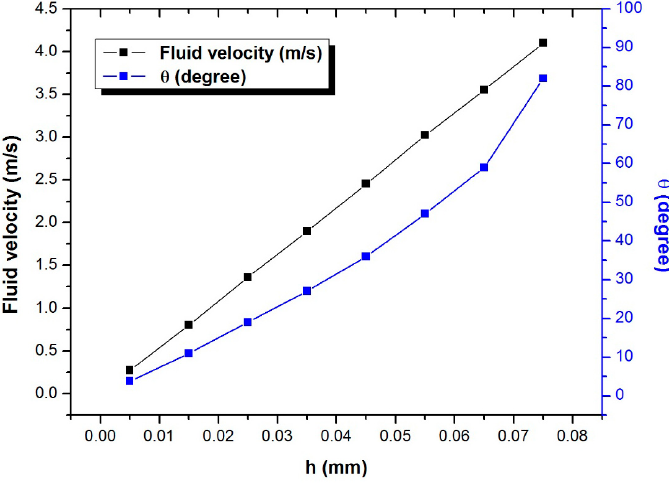
Figure 7. Graph plot showing the relationship between h, θ , and fluid velocity. Fluid velocity was obtained from the simulation study corresponding to the 2 mm fluid channel with a 100 μ m height.